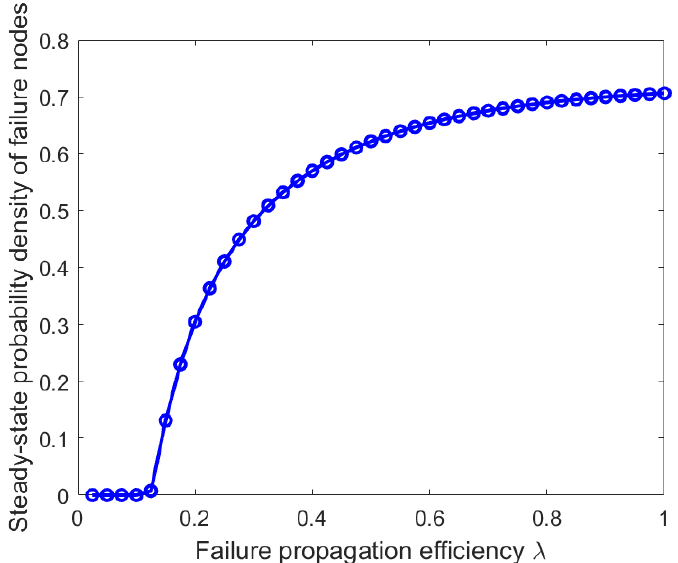
Figure 9. Cyber-physical power system with an assortative link and 236 nodes. In Figure 9, the solid lines refer to the actual edges in the subnetwork, the dashed lines are the inter-layer coupling edges, the red nodes indicate the cyber network, and the green nodes indicate the power network. For the same number of nodes randomly selected as the initial source of infection (failures), the propagation pattern varied between different network topologies. Figure 10 shows the change of steady-state probability density of failure nodes with λ . The main figure shows that for the cyber network, a scale-free network if the primary infection probability is greater than 0, the primary infection will keep propagating and eventually reach a stable state.